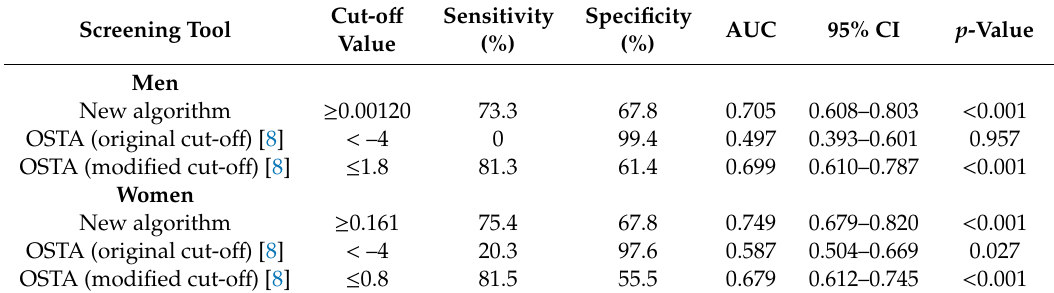
Table5. ComparisonoftheperformanceofthenewosteoporosisscreeningalgorithmswithOsteoporosis Self-Assessment Tool for Asians